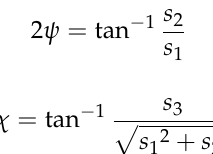
Figure 5. Measured SOP signals from the SOP analyzer while vibration was applied. ( a ) Measured SOPs on the Poincaré sphere. The inset is a zoomed-in image around the SOP trace zone ( α ). ( b ) Corresponding Stokes parameters versus time. S 0 is the measured optical power, and s 1 , s 2 , and s 3 are normalized Stokes